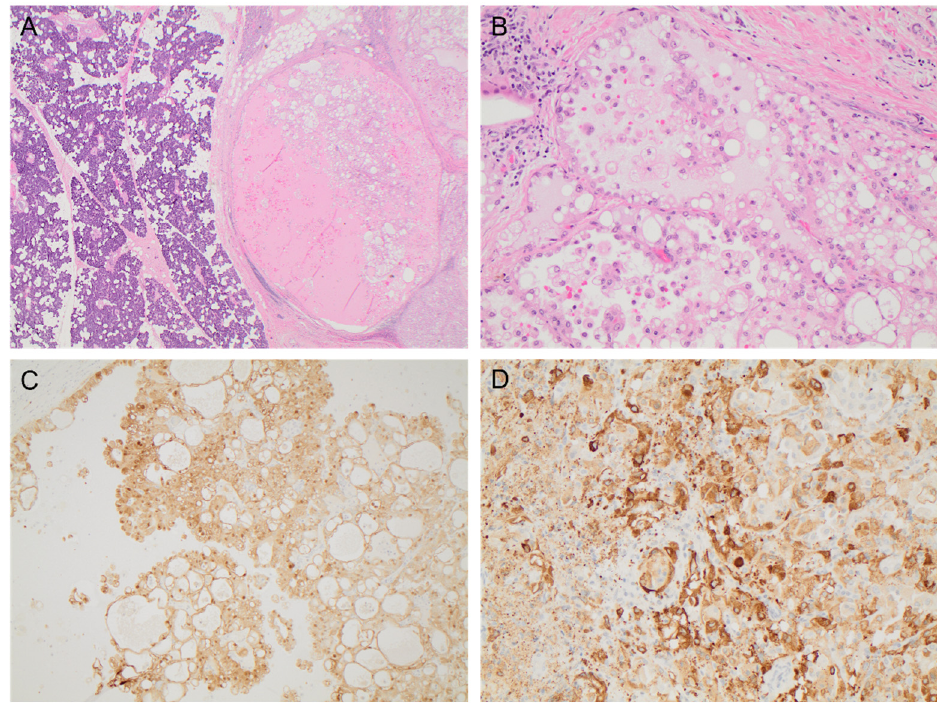
Figure 1. The resected primary parotid mass demonstrated features of SC with ( A ) a well-circumscribed tumor characterized by a vacuolated amphiphilic epithelium and papillary-cystic architecture (H&E, × 20), ( B ) abundant solid areas with microcystic spaces (H&E, 200 × ), and diffuse strong immunohistochemistry staining for ( C ) S100 ( × 100) and ( D ) mammaglobin ( × 200). The patient developed a right pre-auricular, subdermal nodule five years later. Re- peat CT of the neck and chest confirmed the presence of 0.9 × 0.9 cm nodule anterior to the right tragus in the parotid resection bed as well as multiple, bilateral pulmonary nod- ules measuring up to 2.1 × 1.9 cm in the right lower lobe (RLL) and 2.0 × 1.9 cm in the left lower lobe index nodules. Biopsies of the pre-auricular nodule and RLL nodule confirmed